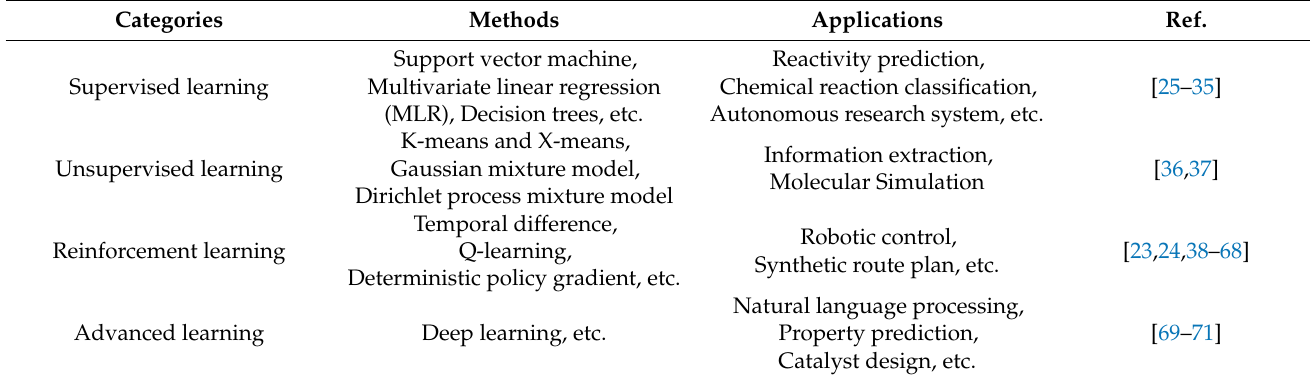
Table 1. Categories of machine learning models and related applications in chemical